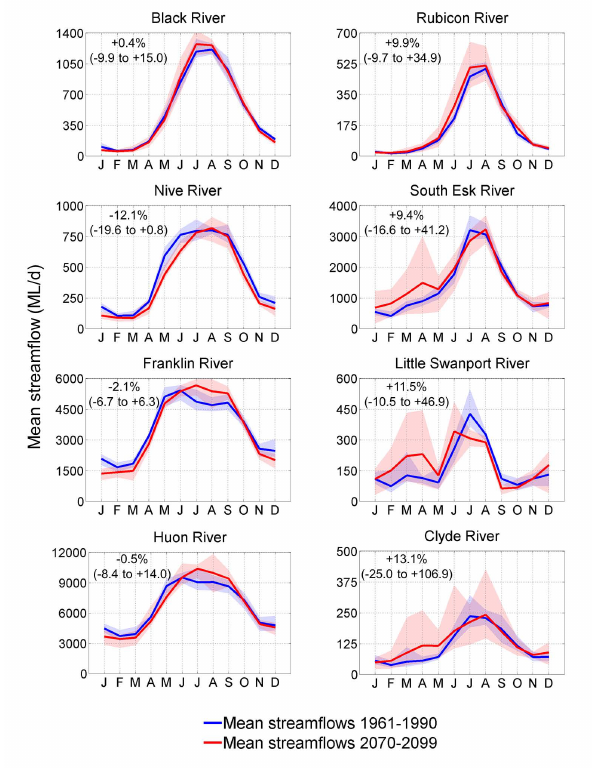
Fig. 13. Mean monthly streamflows simulated by SIMHYD for 1961–1990 and 2070–2099. Shaded confidence intervals show range of the six RCM simulations. Numbers in plots give percent change in mean annual streamflow from the average of the six RCM simulations. Numbers in brackets give the range of percent change from the six simulations.